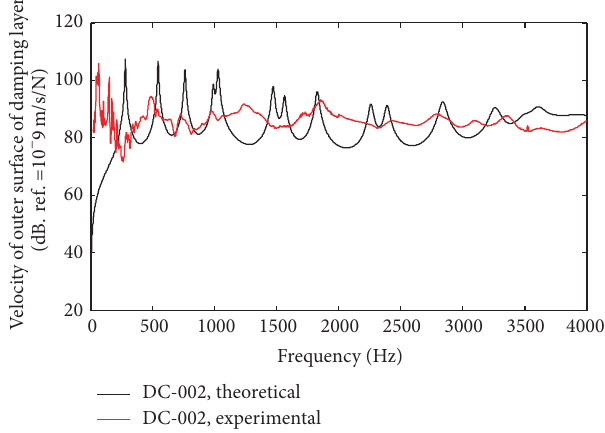
Figure 9: Comparison of theoretical and experimental values of V 2 2